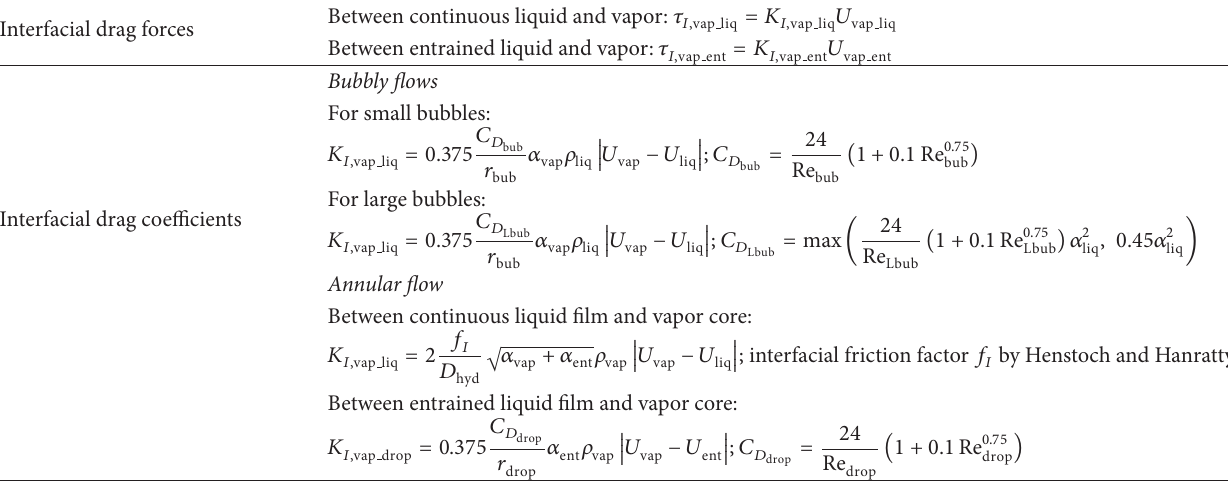
Table 1: CTF modeling of the interfacial